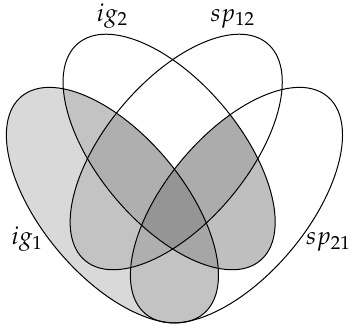
Figure 2. ( a ) Venn diagram for maximal set event solution F M event solution F m . 1